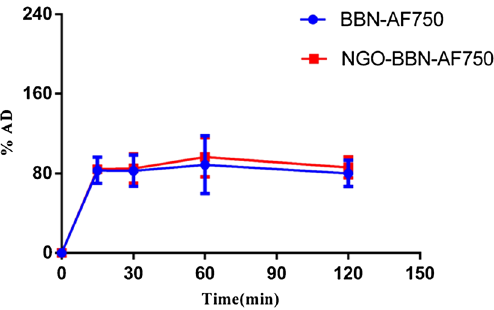
Figure 8. In vitro cell binding studies of AF750-6Ahx-Sta-BBN and NGO-BBN-AF750 at different time at 37 °C.